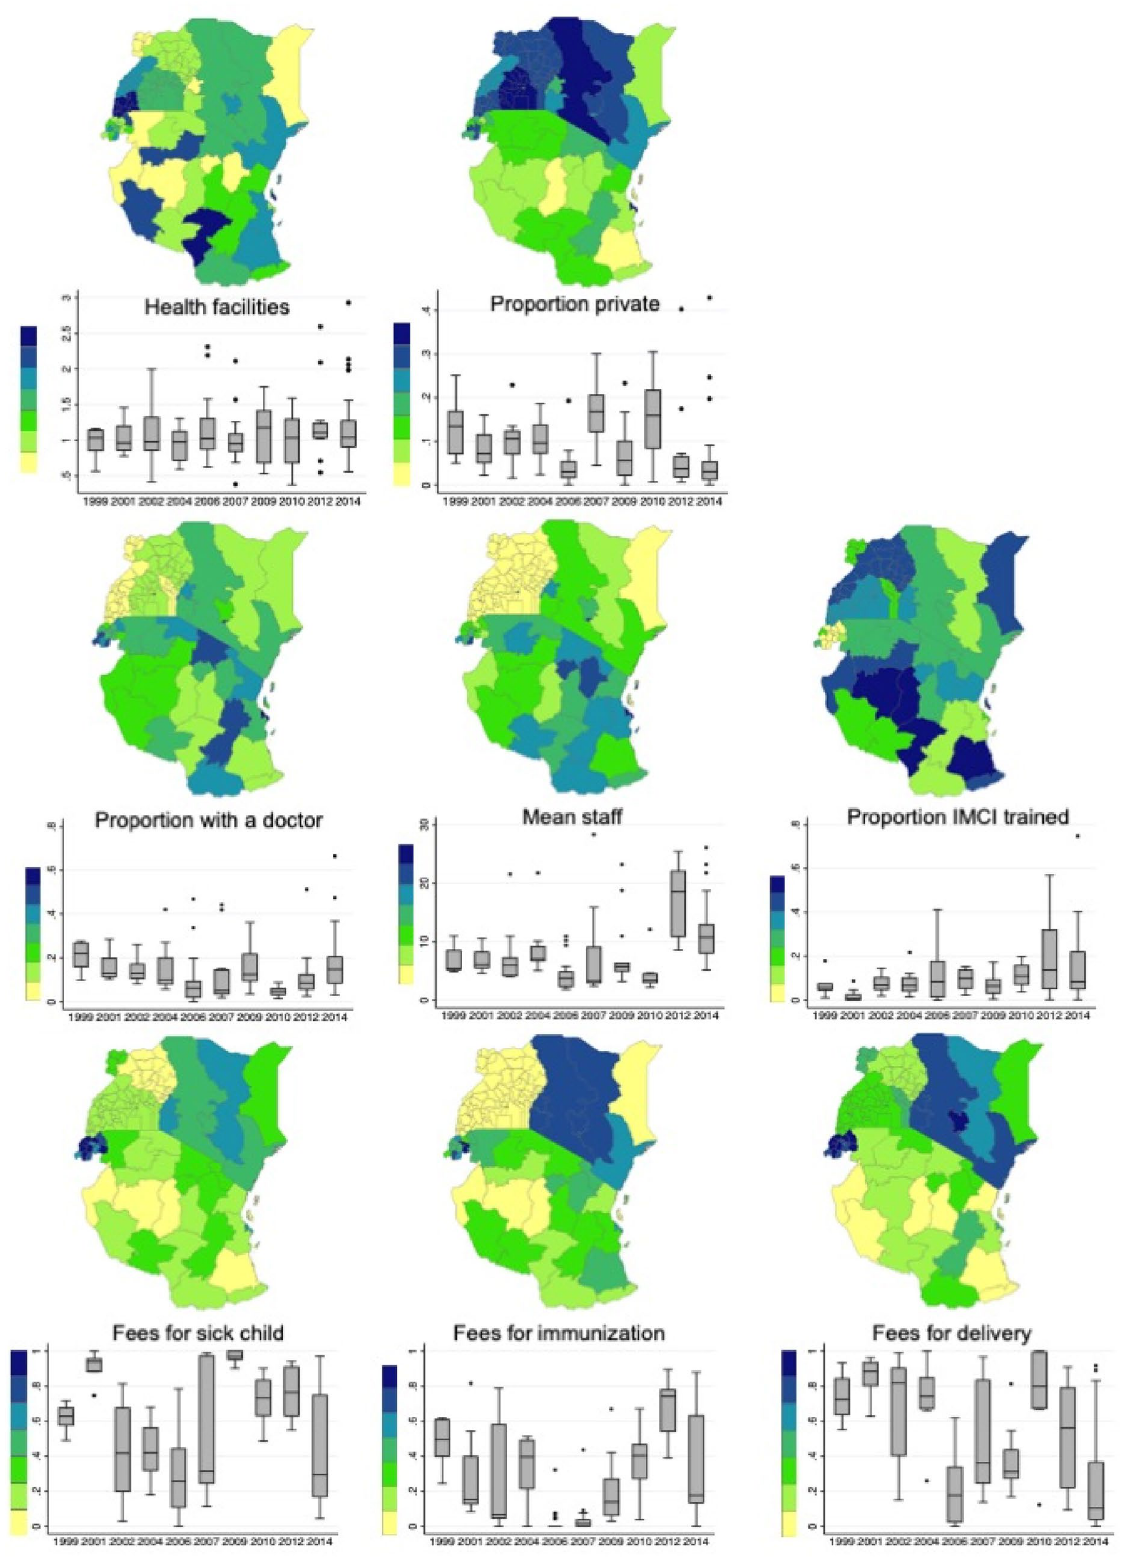
Figure 1. Health system variables by region and year. Maps of region-level means are shown for east Africa to demonstrate variability in space. The box plots show the median and range of each variable by year for all the countries contributing data in that year. Between 7 and 40 (mean = 15) regions are represented in each year of the box plots. Maps were generated in ArcMap 10.7 (Esri Inc., 2019, https:// deskt op. arcgis. com/ en/